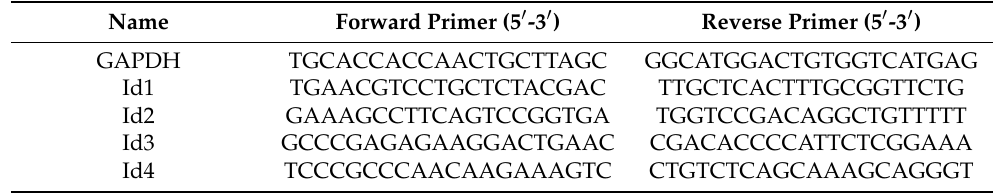
Table 1. Primer list for quantitative